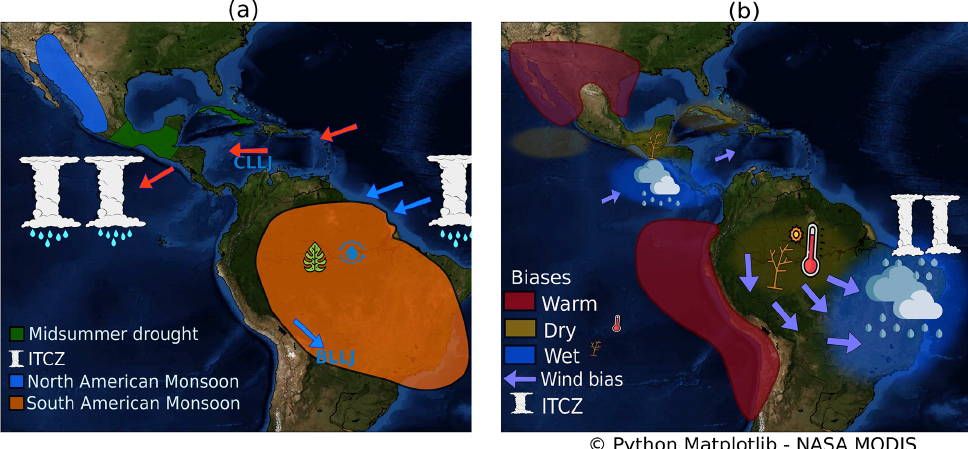
Figure 14. Schematics of (a) the main features in the AMS and (b) the main biases in UKESM1 and HadGEM3. In (a) the boreal summer easterlies (red) and austral summer circulation (blue) are shown with the Caribbean and Bolivian low-level jets (CLLJ and BLLJ, respec- tively). In (b) the biases are shown for the respective Northern Hemisphere and Southern Hemisphere summers. The ITCZ bias in (b) refers to the southward displacement bias of the Atlantic ITCZ in the